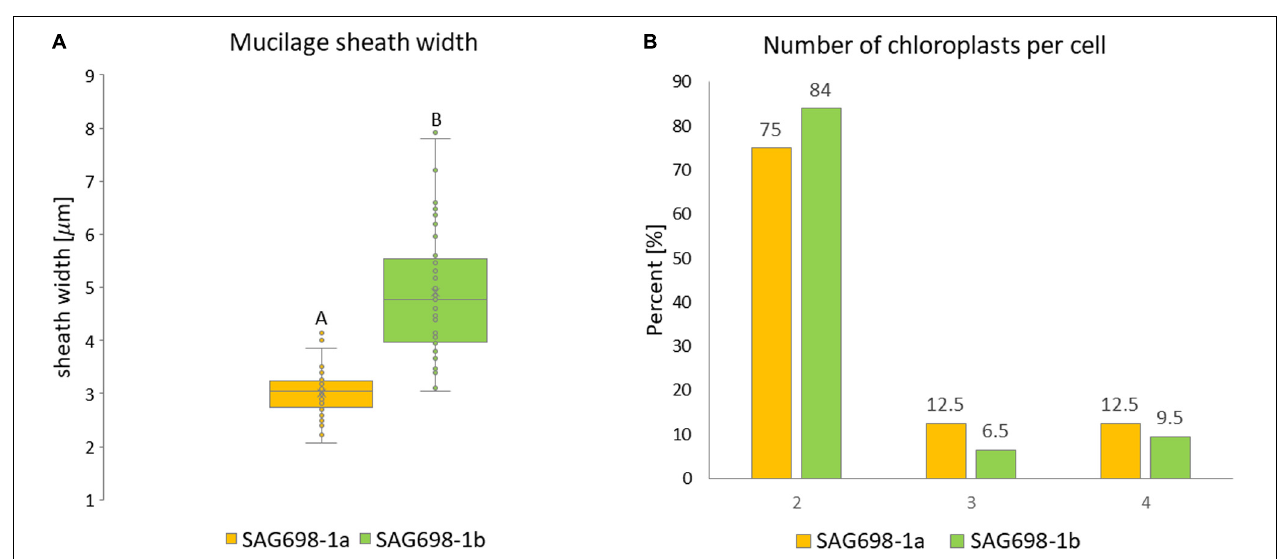
FIGURE 6 | (A) Mucilage sheath width. Statistically significant differences (Mann–Whitney- U -test, p < 0.001) are indicated by different upper-case letters. (B) Chloroplast number per